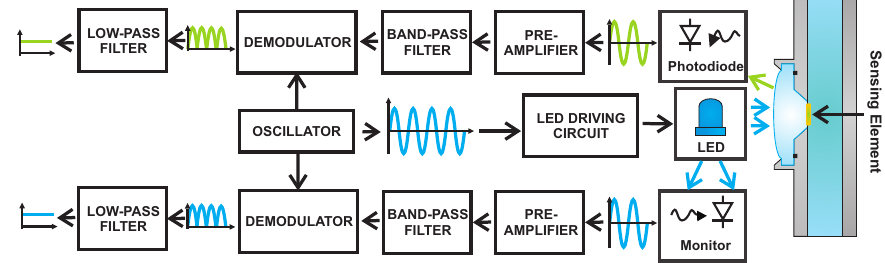
Figure 5. Schematic representation of the electronic board developed and realized to acquire and process the emitted fluorescence signal and the optical power emitted by the LED. The lock-in technique has been used, modulating the LED driving signal and demodulating the collected signal with the same sinusoidal signal. Only the signal of interest presents a non-zero average